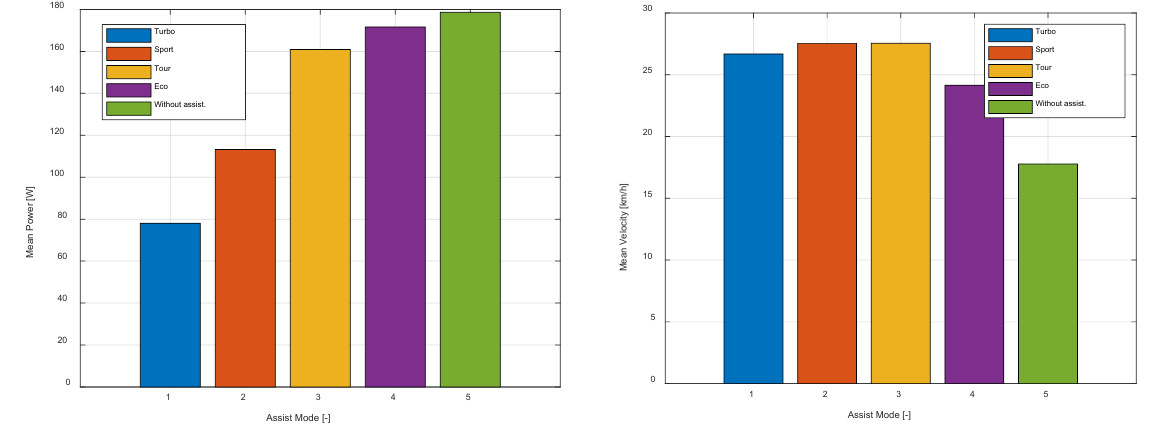
Figure 10. Comparison of average power and speed in different assist modes.